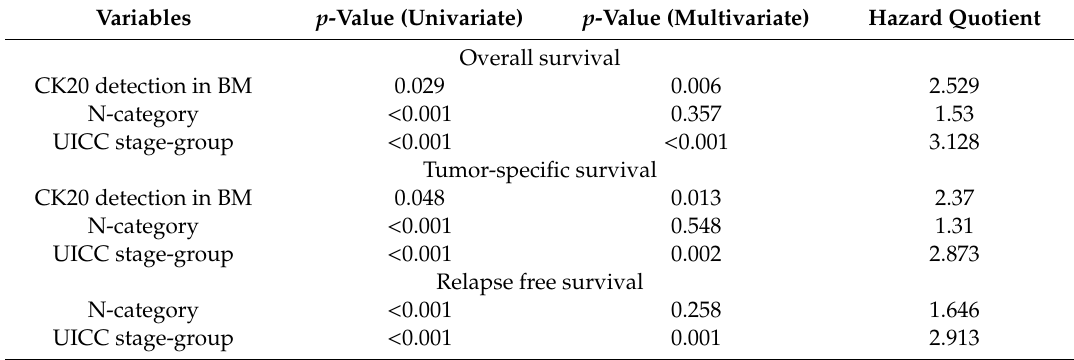
Table 6. Multivariate Cox regression analysis of independent factors influencing overall, tumor-specific and relapse-free survival of esophageal carcinoma